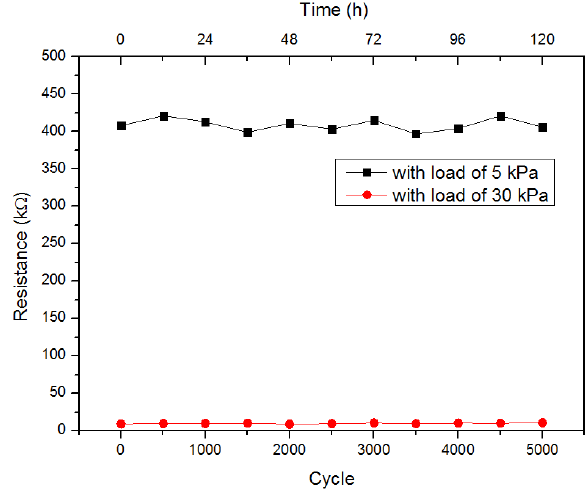
Figure 10. The stability and durability of the pressure sensor with TS029 concentration in PDMS of 50 wt %. The test was performed by applying and removing loads of 5 kPa and 30 kPa for 5000 cycles (500 cycles per 12 h), respectively.